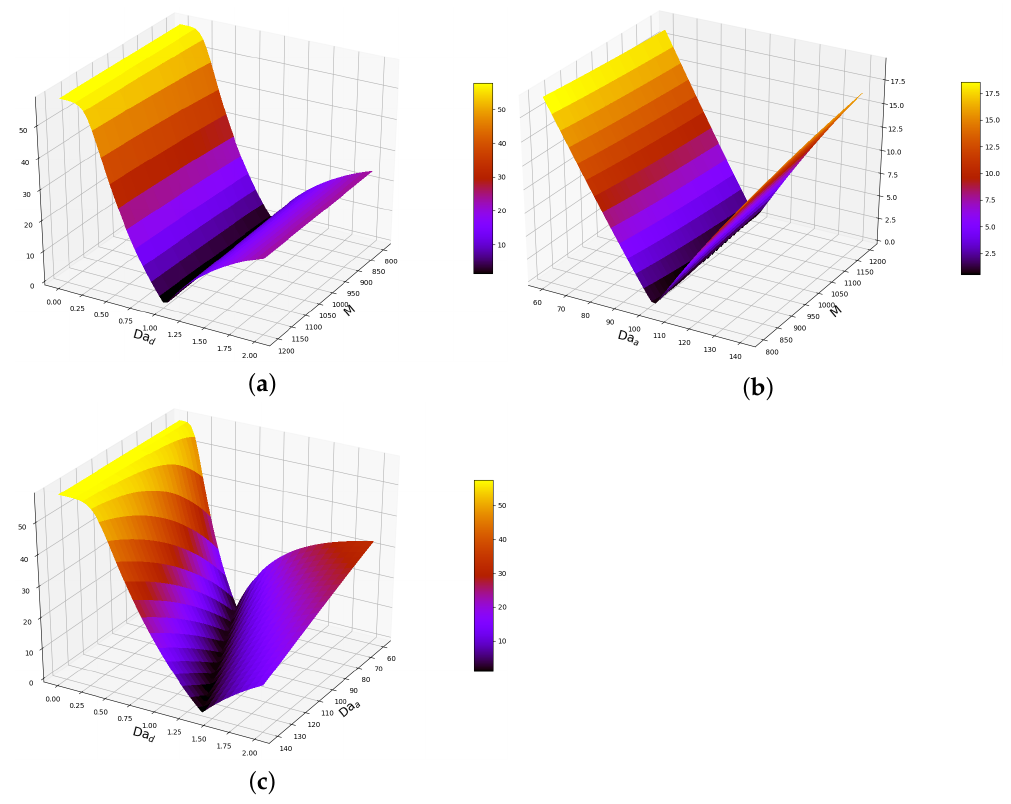
Figure 8. 3D plots for fixed: ( a ) Da a , ( b ) Da d , ( c )